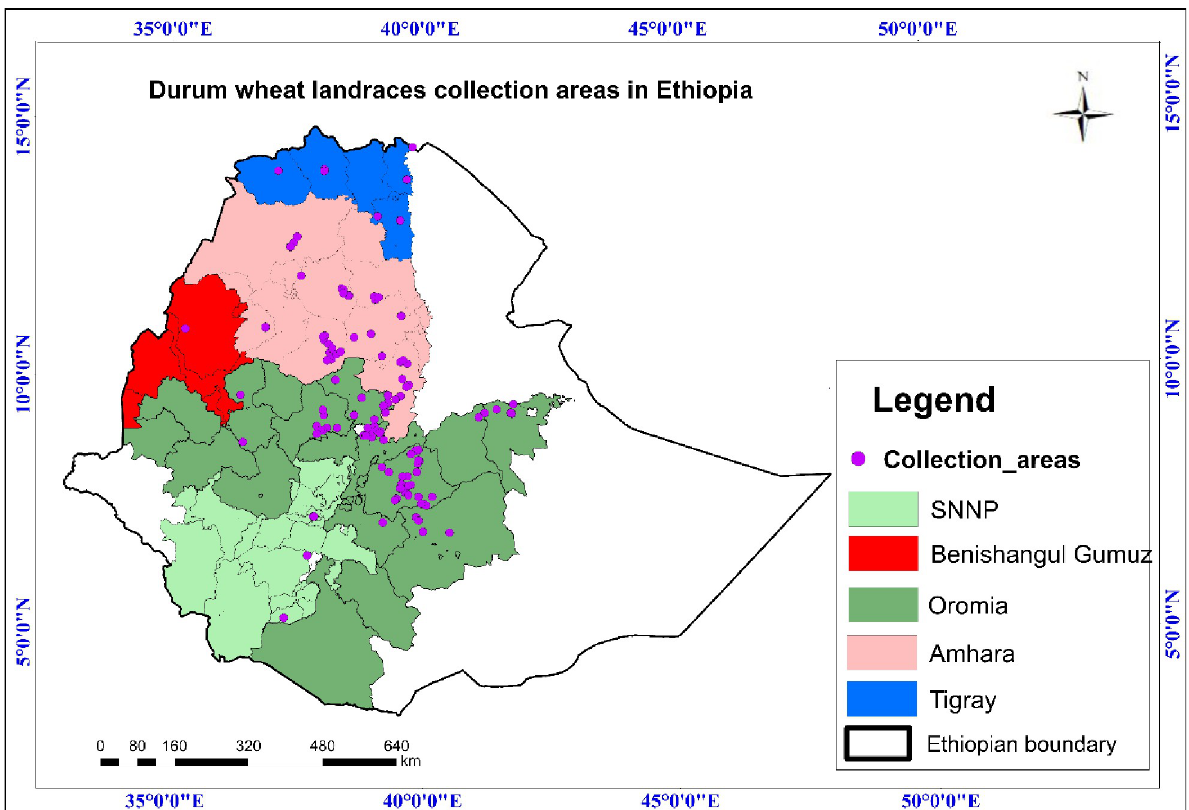
Fig 1. Durum wheat landraces collection areas in Ethiopia. GPS: Geographic position system, Regions of seed origin: South Nation Nationalities and Peoples (SNNP, Light green), Benishangul Gumuz (red), Oromia (green), Amhara (pink), Tigray (blue), Ethiopian boundary and geo-positions were indicated. The mapping was performed using the online ArcGIS software suite vs.